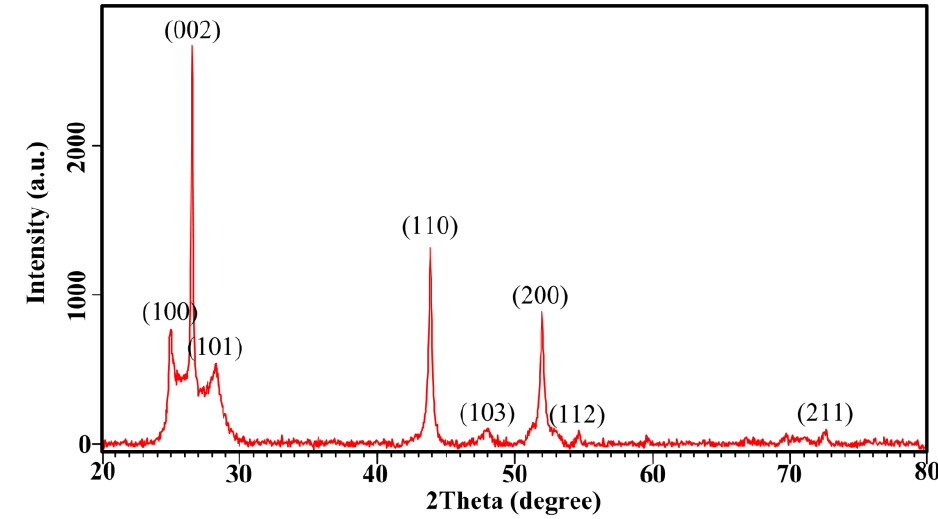
Figure 1. X-ray diffraction pattern of CdSe Figure 1. X ‐ ray diffraction pattern of CdSe nanoparticles.